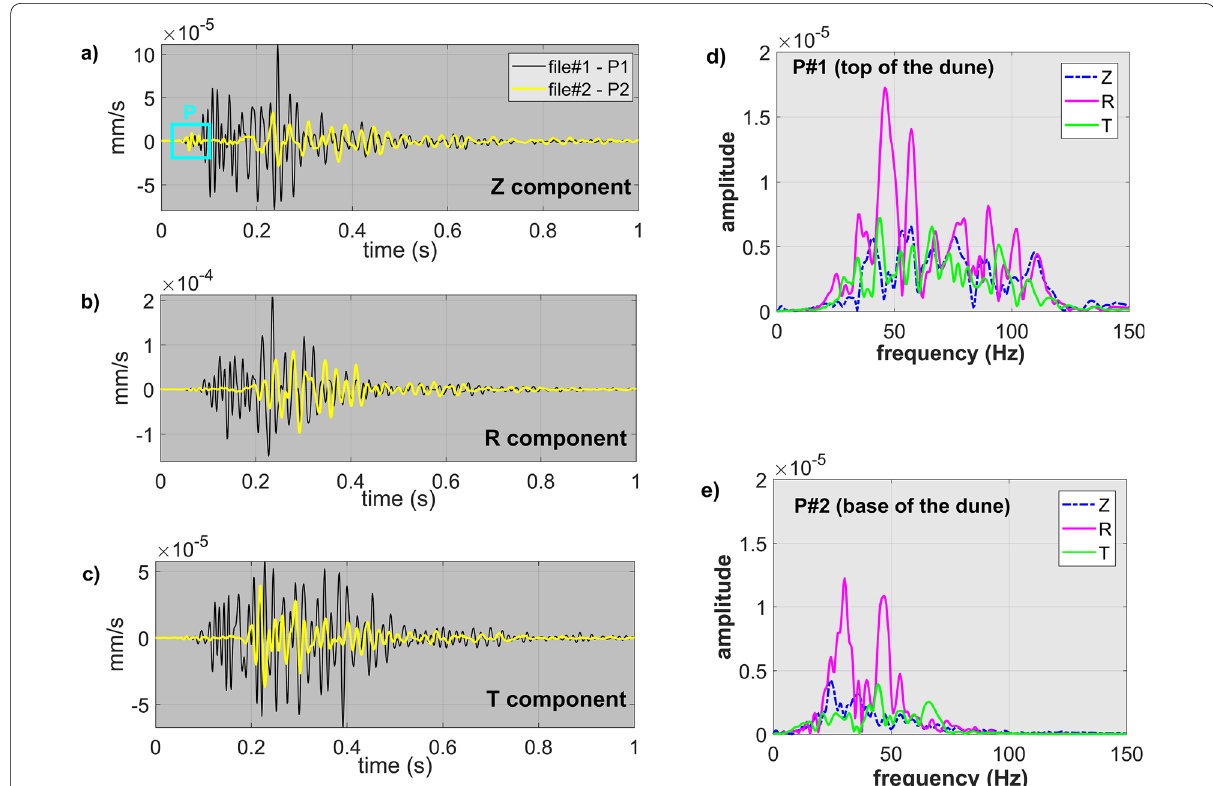
Fig. 6 San Marco area. Comparison of the HS (active) seismic traces collected at P1 and P2 (offset 50 m for both the sites): a Z component (first arrivals highlighted by the P box relate to the P-wave refraction due to the shallow water table at P2) [P1—black line; P2—yellow line]; b R component; c T component (Love waves); d amplitude spectra for the P1 data; e amplitude spectra for the P2 data. See text for